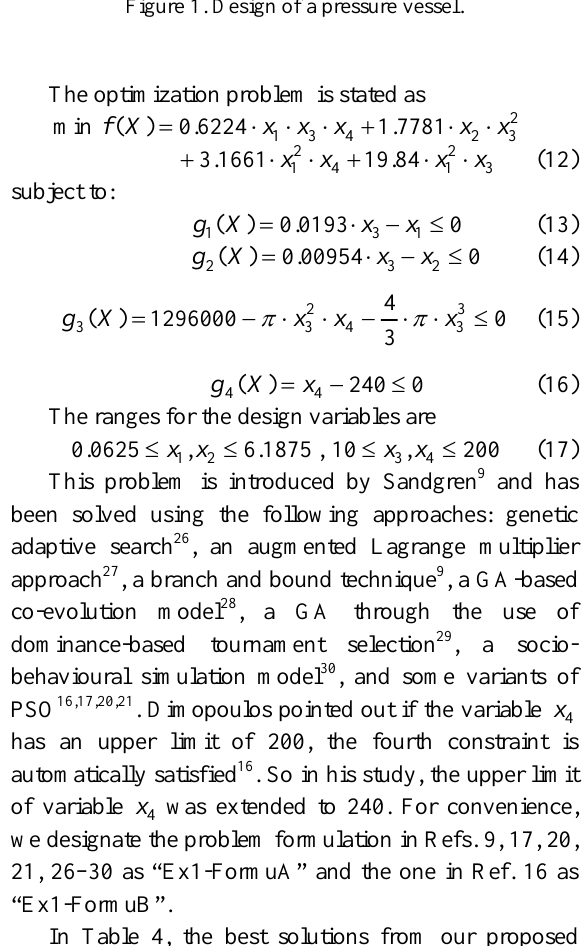
Figure 1. Design of a pressure